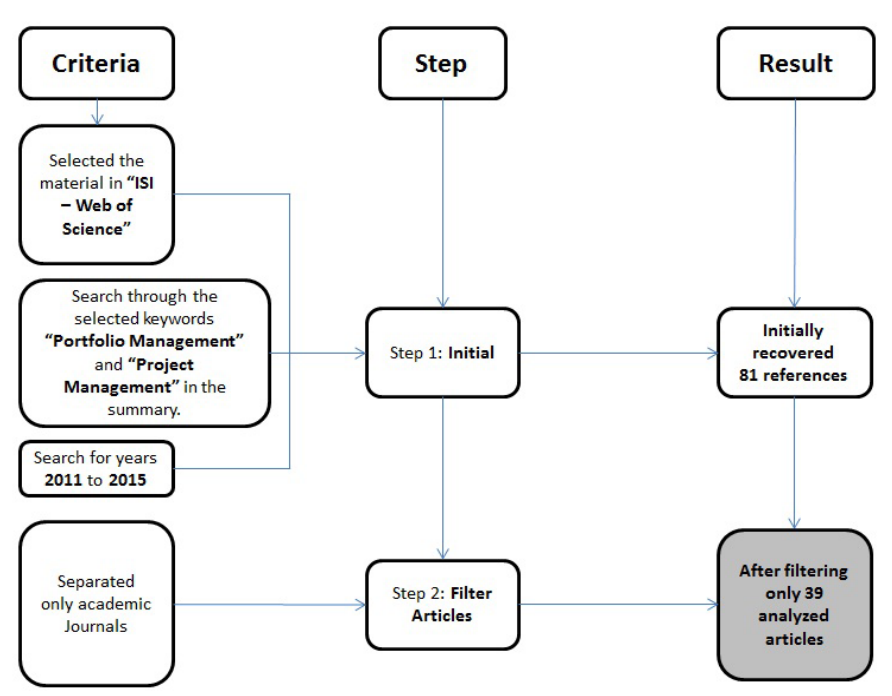
Figure 2. Phases of bibliometrc research between 2011 and 2015 (Baptestone & Rabechini Jr., 2016)